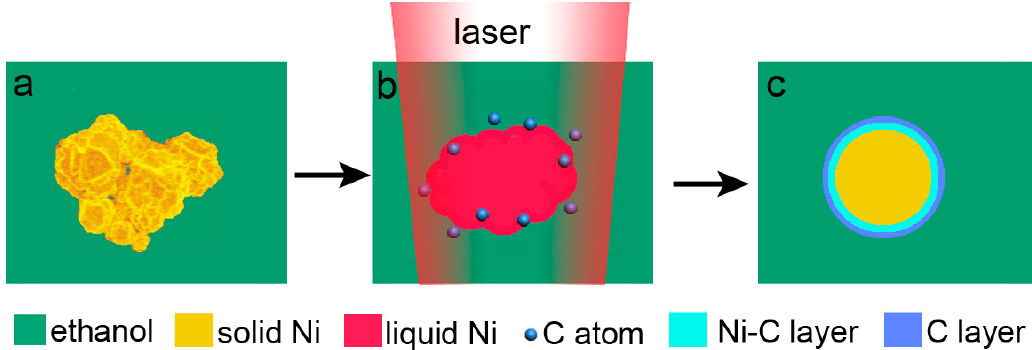
Figure 4 . Schematic illustration of the formation of carbon ‐ encapsulated nickel particles occurring under laser beam irradiation. ( a ) Initial particle; ( b ) molten Ni particle surrounded by pyrolyzed ethanol under laser irradiation; ( c ) final CENP.